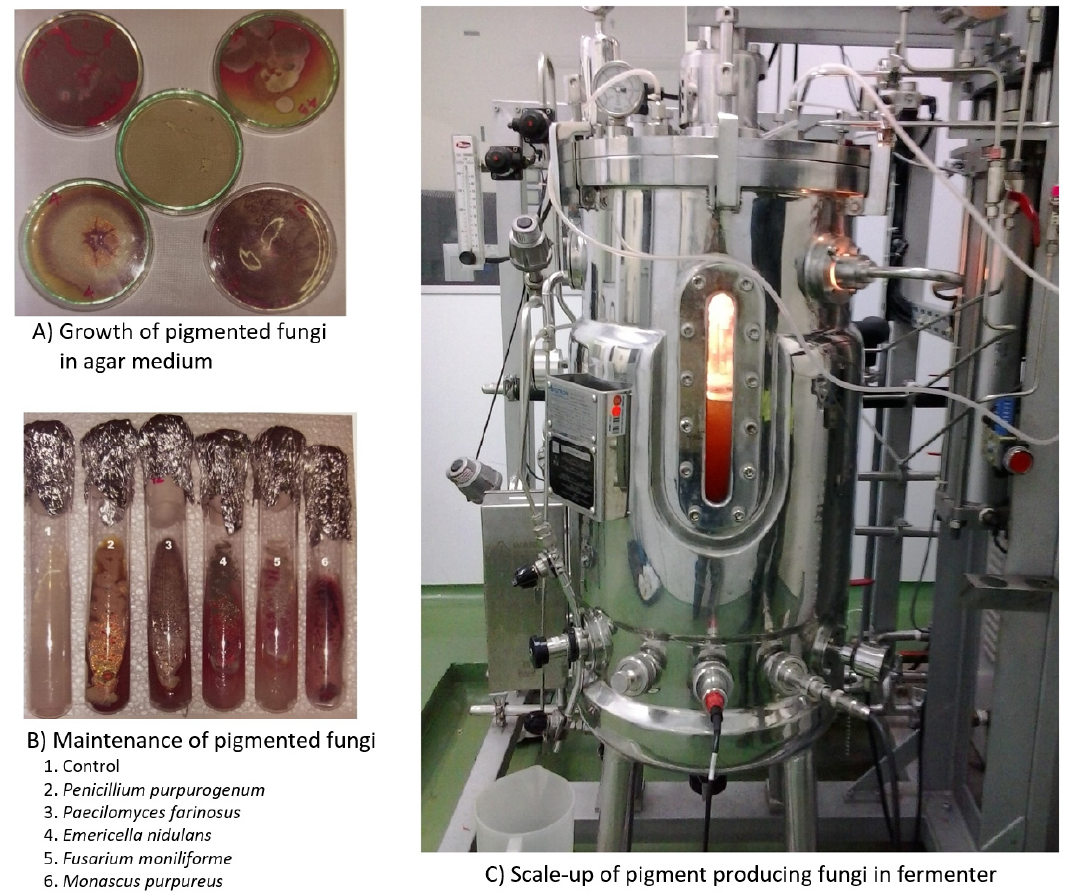
Figure 1. From Petri dish to fermenter: scale-up of pigment producing fungi. ( A ) Growth of pigmented fungi in agar medium; ( B ) Maintenance of pigmented fungi; ( C ) Scale-up of pigment producing fungi in fermenter.